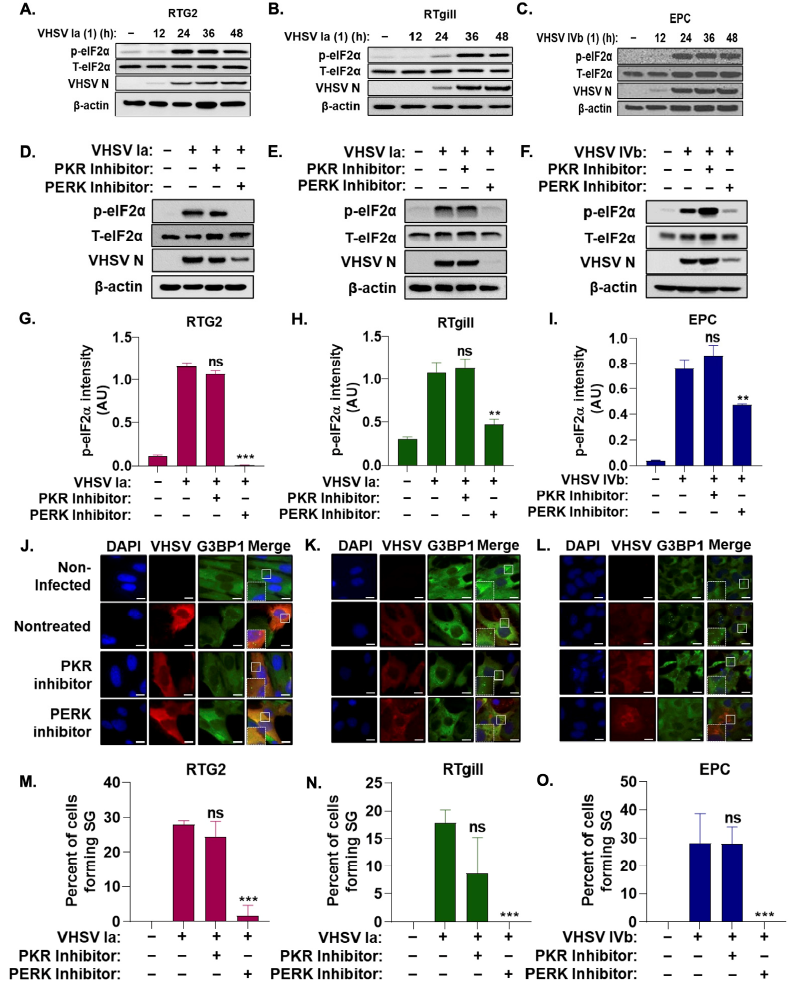
Figure 2. Stress granule induction during VHSV infection requires PERK activation. RTG2 ( A ), RTgill ( B ) were infected with VHSV Ia and EPC ( C ) with VHSV IVb (MOI = 1.0 pfu/cell) and cell lysates at indicated times was analyzed by immunoblotting with antibodies against, p-eIF2 α , T-eIF2 α , VHSV and β -actin. RTG2 ( D ), RTgill ( E ) and EPC ( F ) cells were treated with PERK inhibitor, or PKR inhibitor for 1 h prior to infection with VHSV Ia (RTG2, RTgill) or VHSV IVb (EPC) for 48 h and cell lysates analyzed by immunoblotting with antibodies against, p-eIF2 α , T-eIF2 α , VHSV and β -actin. ( G – I ) Quantification of ( D – F ). RTG2 ( J , M ); RTgill ( K , N ) and EPC ( L , O ) cells were treated with PERK or PKR inhibitor for 1 h prior to infection with VHSV Ia (RTG2, RTgill) or VHSV IVb (EPC) for 48 h and stress granule formation and infected cells were analyzed by staining with antibodies for G3BP1 or VHSV ( J – L ). Percent cells forming SG in ( J – L ) were quantitated ( M – O ). Data represents mean ± SD. Scale bar 1 μ m; ns: not significant; **, p < 0.01; ***, p < 0.001, ns = “not significant”.